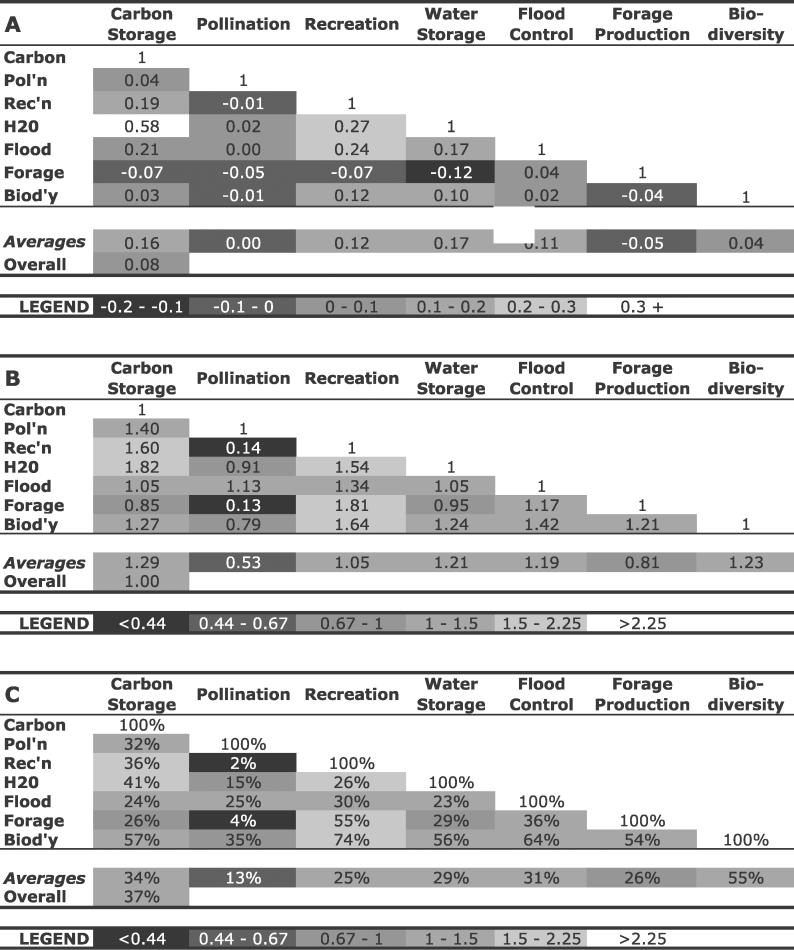
Pair-Wise Spatial Associations between Biodiversity and the Production of Ecosystem ServicesAssociations are expressed as (A) the correlation coefficient (r) between feature values; (B) actual/expected number of planning units shared between best networks; and (C) actual number of shared planning units as a percentage of the smaller network. Arithmetic averages for each ecosystem service with each other ecosystem service are also noted. Shading indicates strength of correlation/overlap, as indicated by the legends. The shading in (C) follows values in (B). All correlations are statistically significant except for pollination with recreation, flood control, and biodiversity. All overlaps are statistically significant by G-tests for goodness of fit.